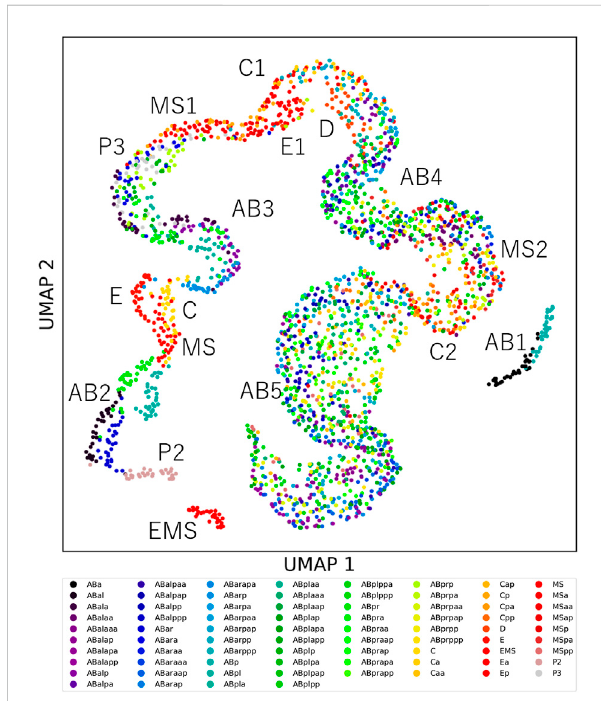
FIGURE 3 Theuniquenessofcellmorphodynamics.UMAPprojectionofthe 76 types of cells in the 32 embryos by using the integral RMSDs as the distance matrix. Colors indicate the cell types. Labels indicate the generationnamesofthecells,represented bylineage namesand division times from the founder cell, such as AB2 for ABal, ABar, ABpa, and